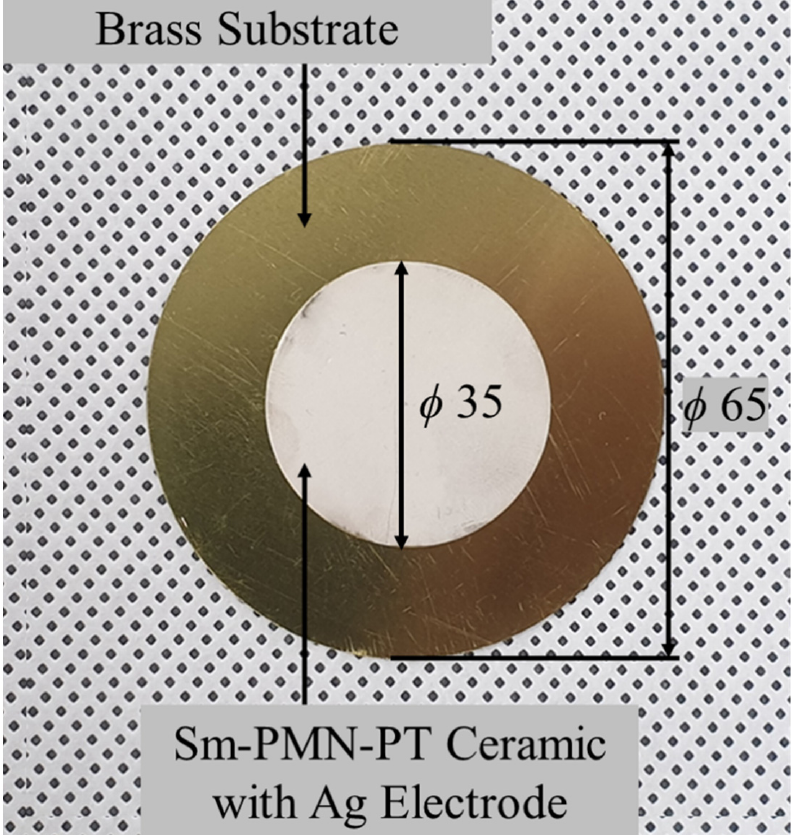
Figure 1. Photo images of fabricated buzzer-type piezoelectric energy converter. Table 1. Dielectric and piezoelectric properties of Sm-PMN-29PT piezoelectric ceramic. Piezoelectric